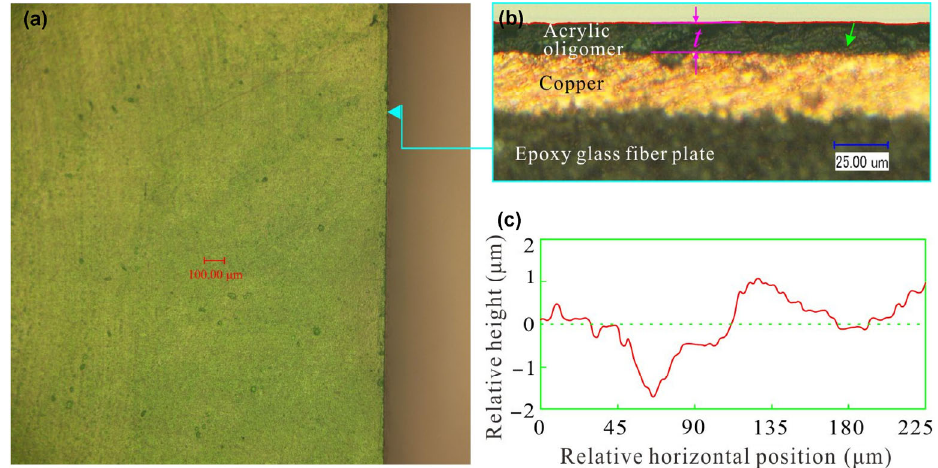
Fig. 3 The surface profile of the substrate. (a) A top view of the probe surface. (b) A lateral view of the section of the probe. (c) A typical surficial profile of the probe